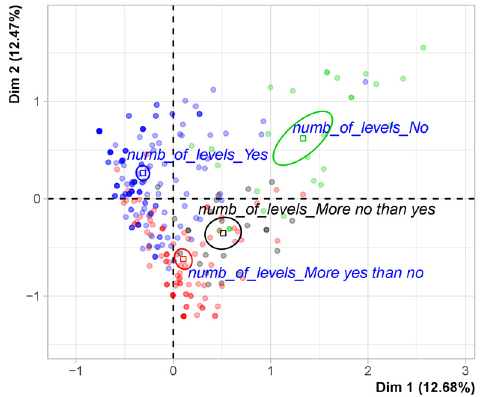
Figure A7. MCA. Distribution of respondents by attitudes towards flatter organizational structures.